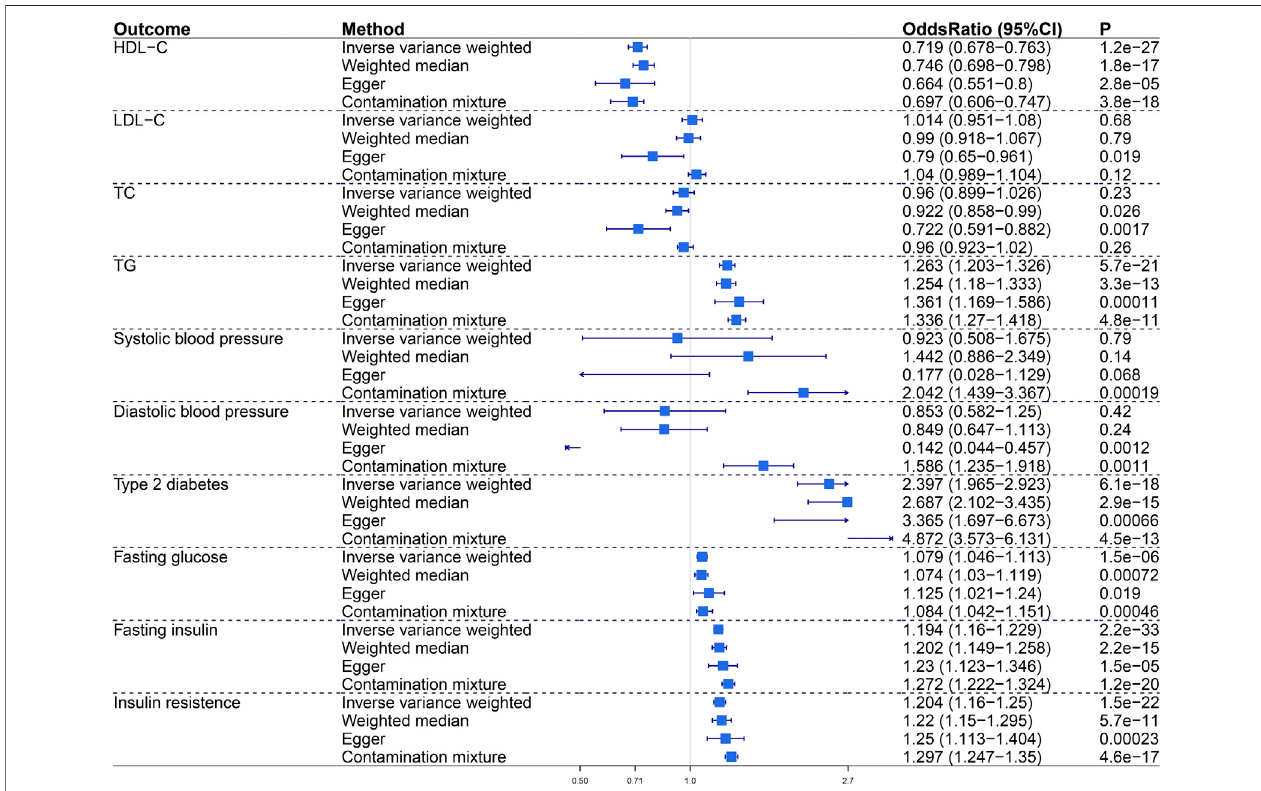
FIGURE 1 | The causal effect of visceral adiposity on 10 metabolic risk factors. Odds ratios are expressed per 1-SD increase in genetically determined VAT mass. CI, con fi dence interval; HDL-C, high-density lipoprotein cholesterol; LDL-C, low-density lipoprotein cholesterol; TC, total cholesterol; TG, triglycerides.